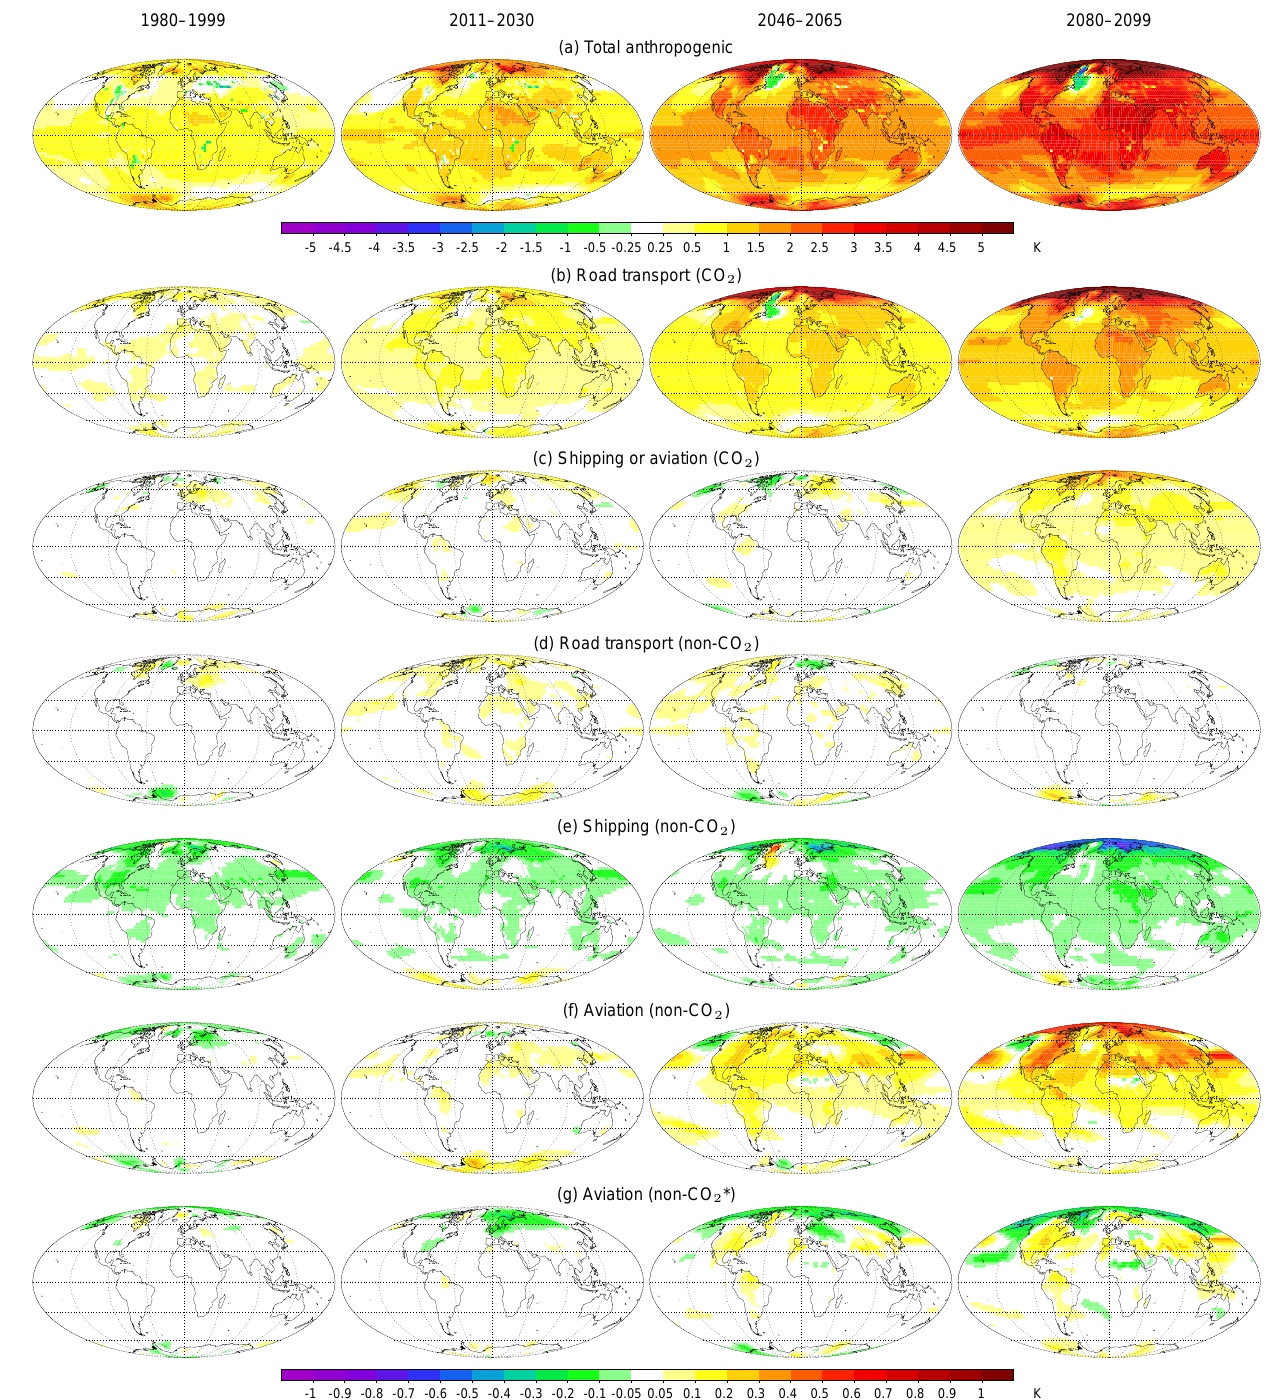
Fig. 10. Global maps of the annual mean surface air temperature impact in the periods 1980–1999, 2011–2030, 2046–2065 and 2080–2099 caused by (a) the total anthropogenic forcing, the CO 2 forcing from (b) road transport and (c) shipping or aviation, by the non-CO 2 forcing from (d) road transport, (e) shipping and (f) aviation where we use the dynamical O 3 approach to take into account the effect of O 3 , and (g) by the non-CO 2 * impact from aviation (using the fixed O 3 approach). Notice that the contour intervals are 5 times larger for the total anthropogenic perturbation (a) .